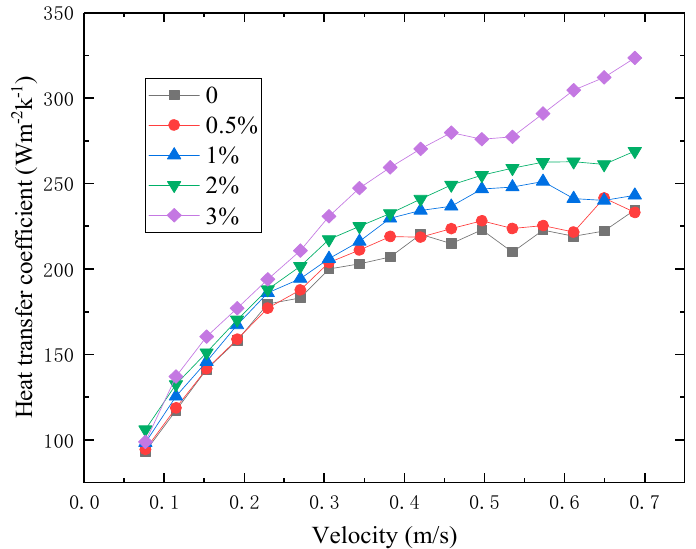
Figure 12. Heat transfer coefficient of prepared nanofluid samples at different velocities.